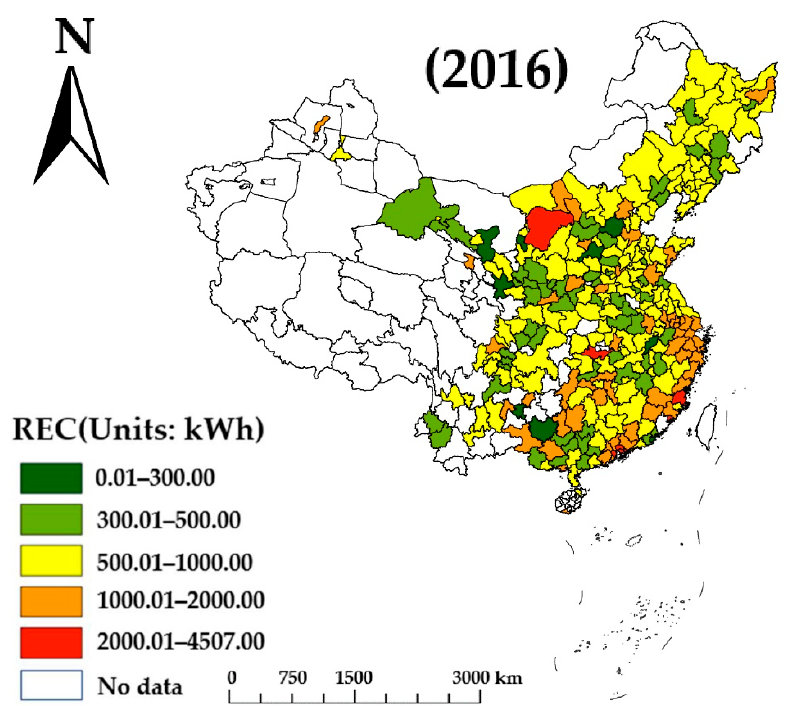
Figure 3. Spatial pattern evolution of China’s REC in 2010.